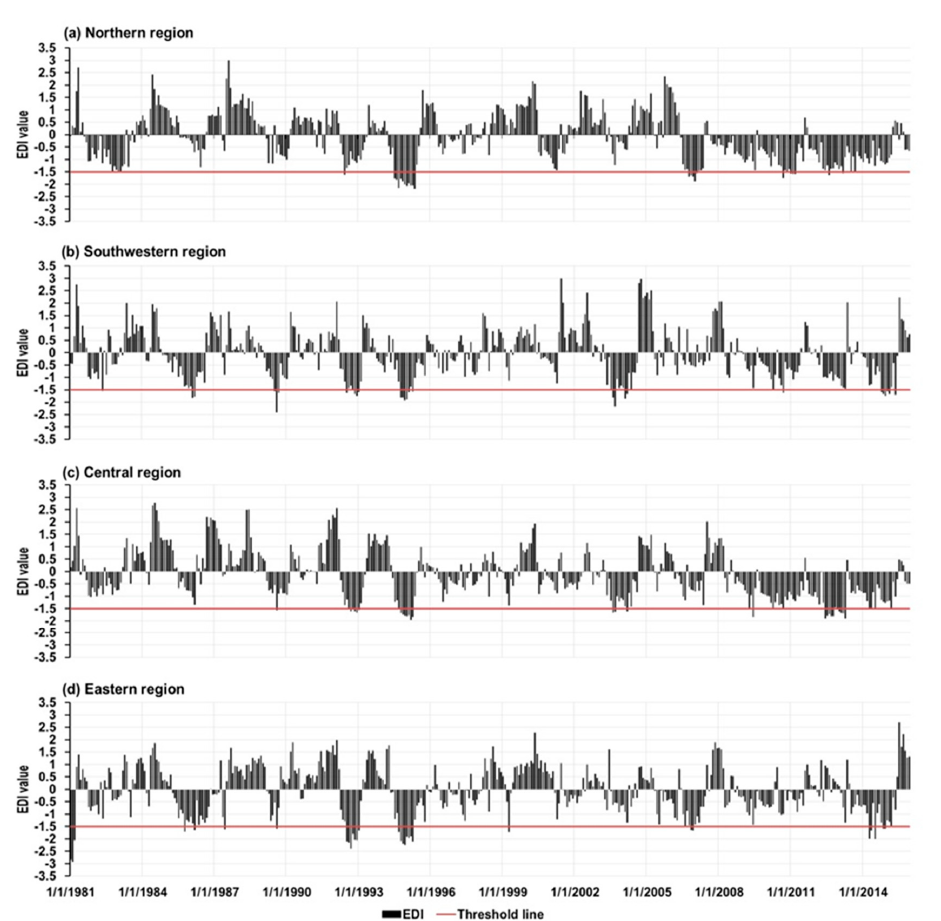
Figure 5. EDI values calculated from observed rainfall data at ( a ) northern (5 stations), ( b ) south-western (9 stations), ( c ) central (4 stations), and ( d ) eastern (9 stations) sub-regions of Bangladesh during 1981– 2015.